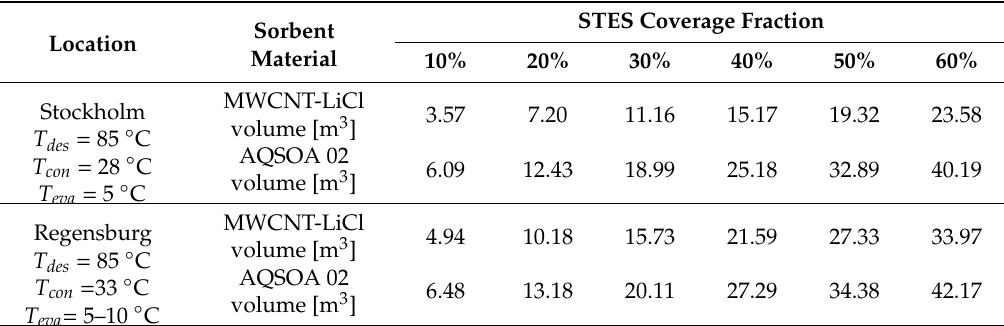
Table 6. Expected volume of multi-wall carbon nanotubes (MWCNT)-LiCl and AQSOA, to cover di ff erent space heating energy demand for NZEB in residential Swedish and German